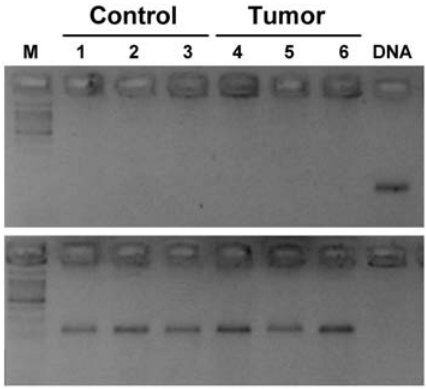
Figure 4. Absence of Lasc1 gene expression in mouse normal lung and lung tumors of (A/J 6 C57BL/6J)F1 mice. The ethidium bromide-stained gel shows the RT-PCR results: lanes 1–3, normal lung derived from adult mice; lanes 4–6, lung tumors derived from urethane- treated mice; lane M, DNA size marker; lane DNA, genomic DNA. Only genomic DNA (top panel) and the Itpr2 housekeeping gene (bottom panel) were amplified.